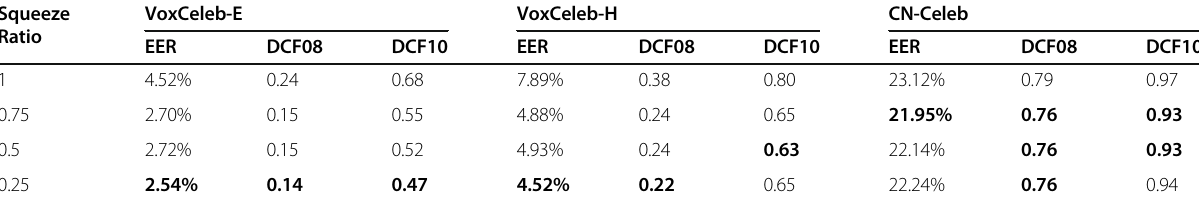
Table 5 The effect of different channel squeeze ratios on recognition performance Squeeze Ratio